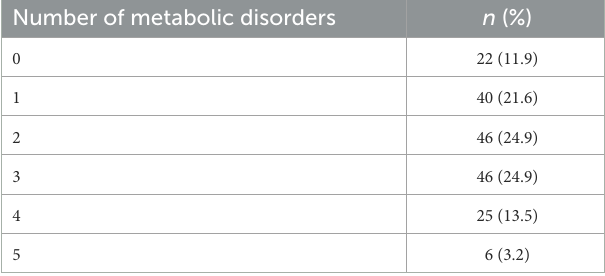
TABLE 4 The distribution of South African minibus taxi drivers by the clustering of MetS